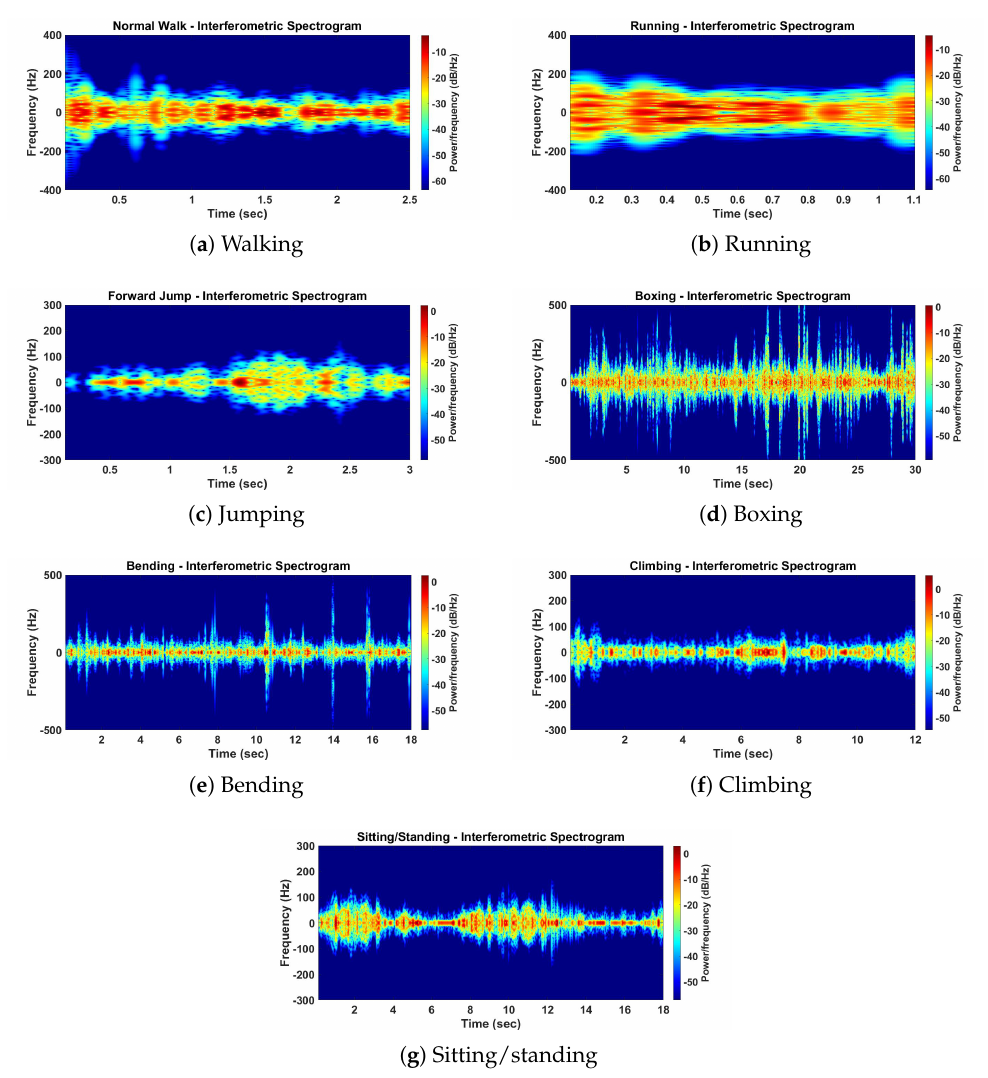
Figure 5. Interferometric spectrogram (left to